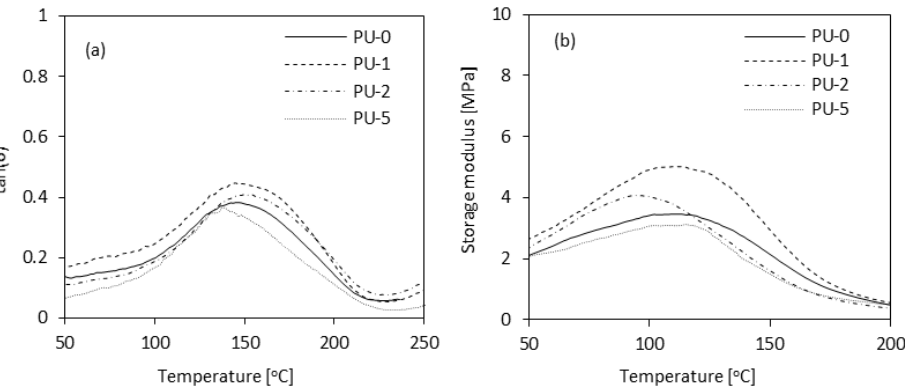
Figure 14. Dynamic mechanical analysis of PUR composite foams—( a ) Tan δ and ( b ) storage modulus as a function of temperature. Adapted from Ref.